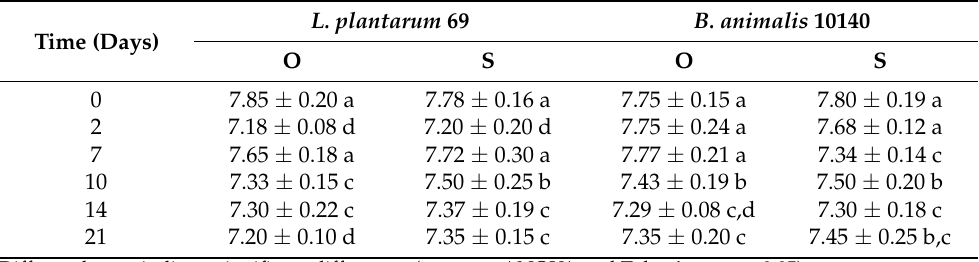
Table 4. Cell counts (log CFU/g) of L. plantarum 69 and B. animalis subsp. lactis DSM 10140 in fish samples (mean ± standard deviation). O, packaged in sunflower oil; S, packaged in brine. Time